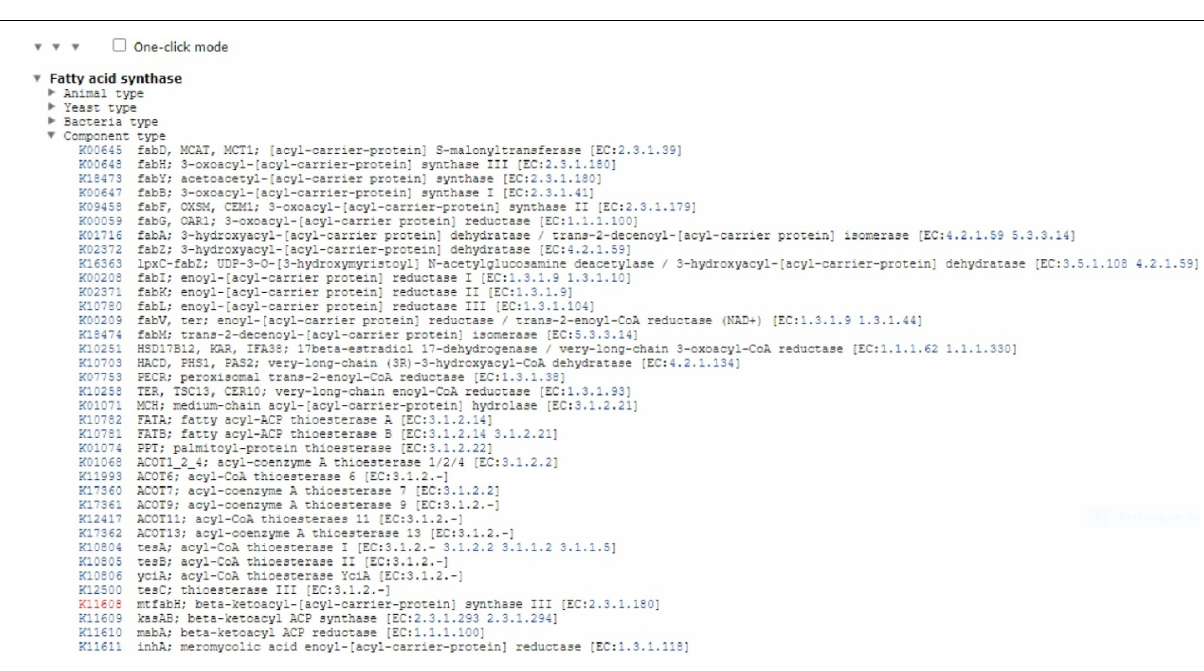
FIGURE 2 | Fatty acid synthase hierarchical classification studies from BRITE